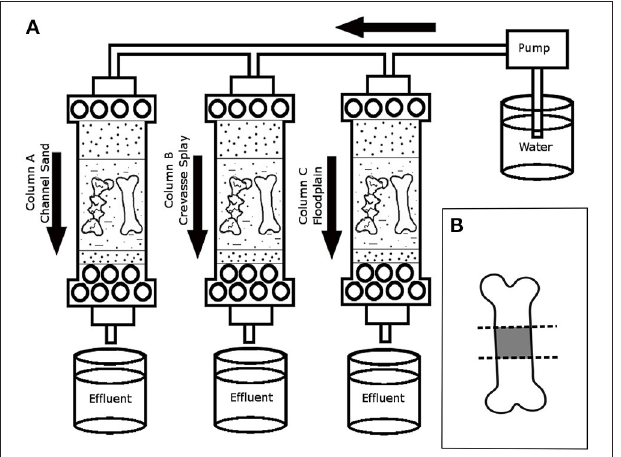
FIGURE 2 | Schematic of experimental columns. (A) Placement of bone samples and water flow to the six columns over the duration of the experiment. Effluent water was collected regularly to test variability in pH. (B) Schematic of section of bone samples following experiment. Diaphyseal portion of the bone samples (in gray) were used in SEM